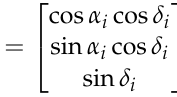
Figure 1. Coordinate system in attitude determination. According to the transformation relationship between the spherical coordinate system and the rectangular coordinate system, the direction vector of the navigation star i in the celestial coordinate system can be expressed as [24]: